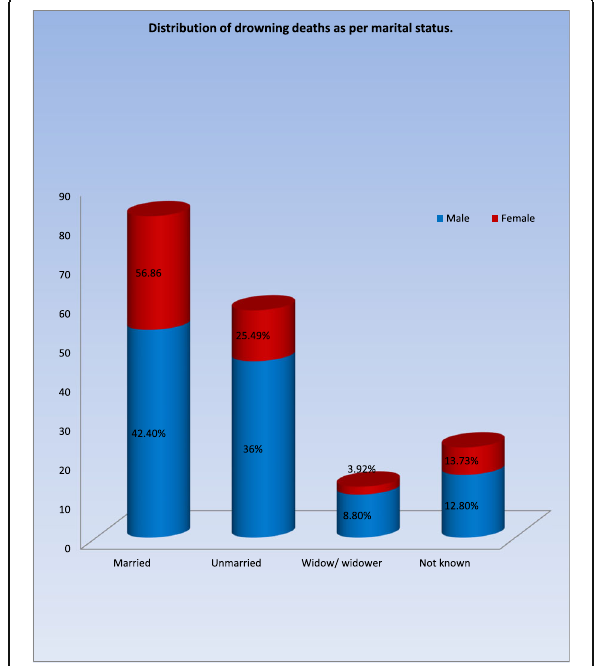
Fig. 2 Distribution of drowning deaths as per marital status of victims